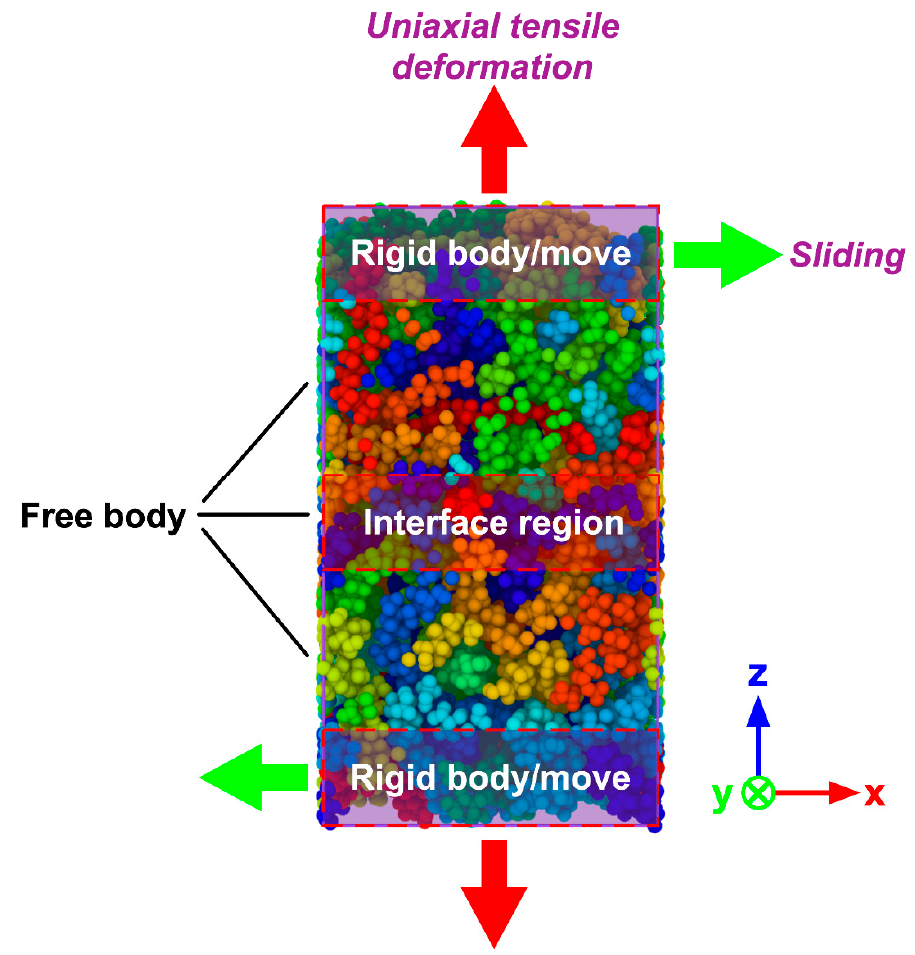
Figure 2. Molecular model of hybrid PA66–PP system for uniaxial tensile and sliding deformation.